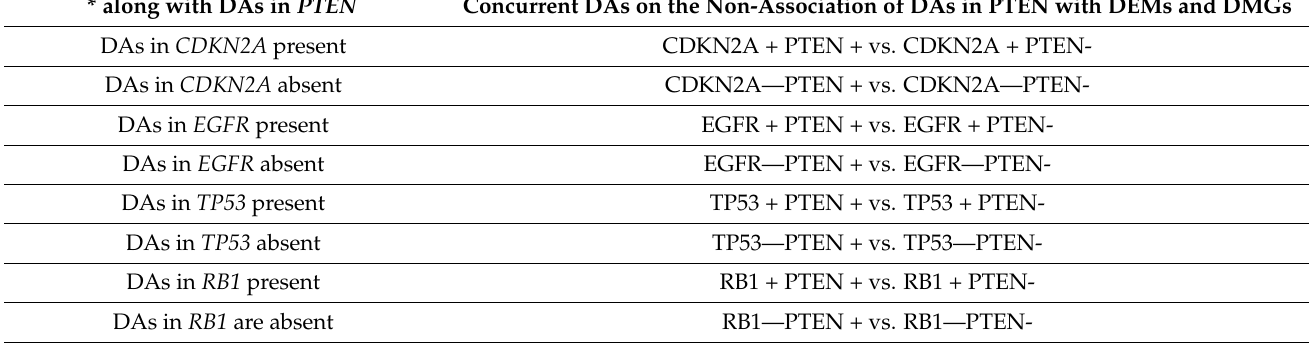
Table 1. DAs in PTEN on DEMs and DMGs; groups of cases with combinations of appropriate DAs were